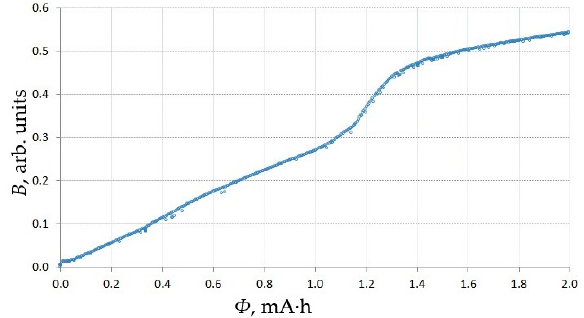
Figure 20. Changes in the image brightness B vs. the accumulated integral of the proton current Ф .